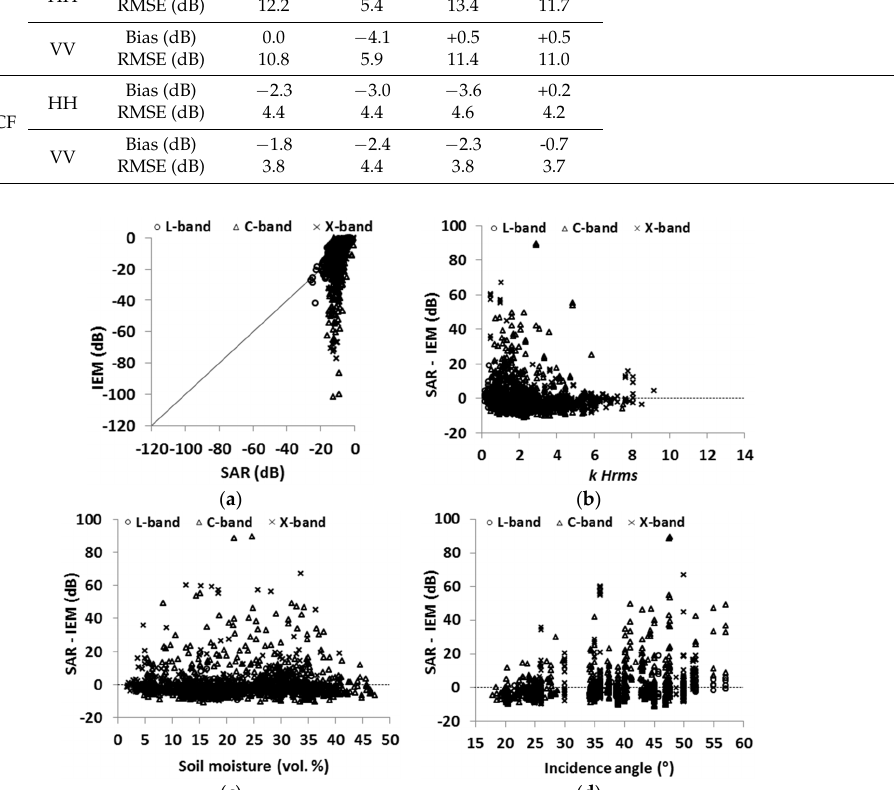
IEM_B with Lopt using GCF